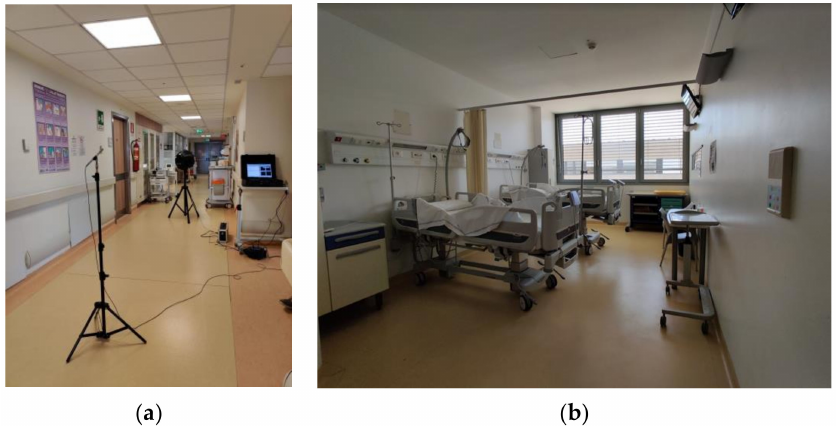
Figure 4. Careggi General Hospital of Firenze during measurements: ( a ) on the left side the corridor and ( b ) on the right side the